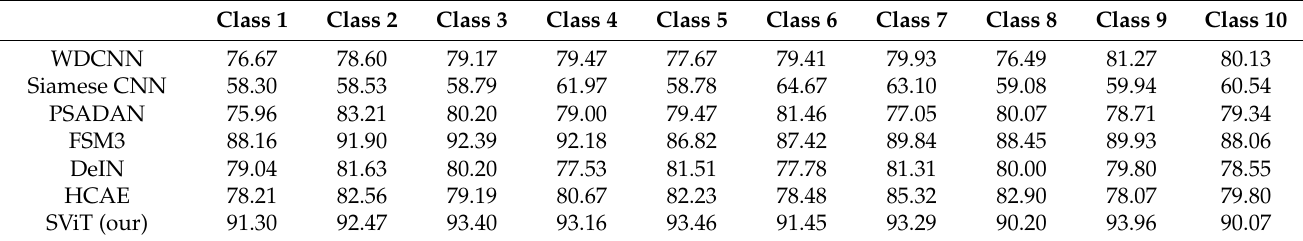
Table 9. Precision (%) comparison for cross-domain task C-A with 6000 training samples on CWRU. Class 1